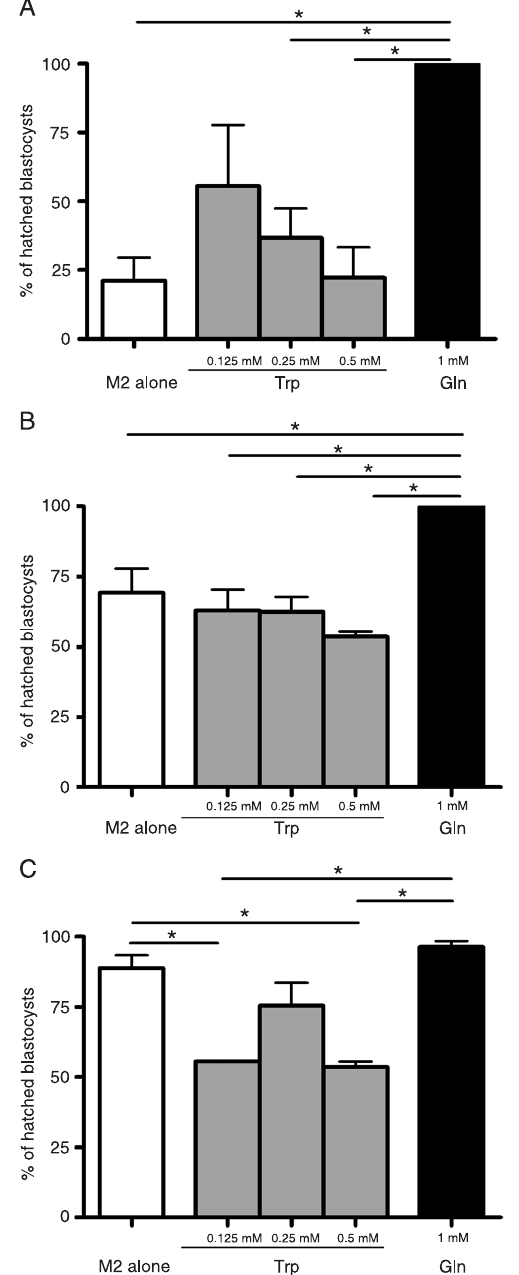
Figure 2. Induction of blastocyst hatching by Gln. The figure shows the percentage (means ± SEM) of hatched blastocysts at 24, 48, and 72 h of incubation in M2 medium alone (open bar), or medium plus 0.125 mM Trp, 0.25 mM Trp, 0.5 mM Trp (gray bars), or 1 mM Gln (black bar). Hatching of the blastocysts cultured in M2 medium containing 1 mM Gln was significantly higher than in the other conditions at 24 (A) and 48 h (B). Embryo hatching did not increase in the groups stimulated with 0.125 and 0.5 mM Trp at 72 h (C) compared to 48 h. *P < 0.05 (one-way